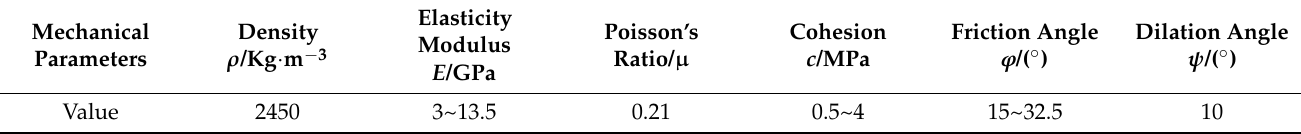
Table 1. Physical and mechanical parameters of surrounding